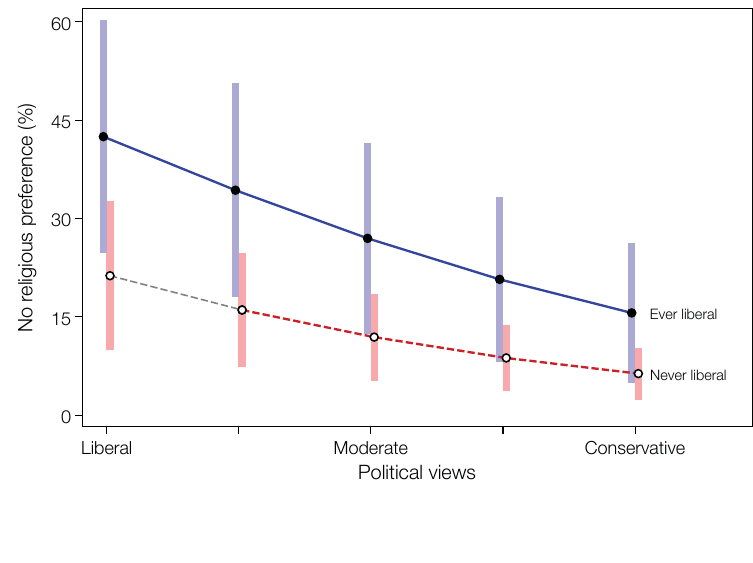
Figure 8a: Percentage with No Religious Preference by Political Views: Persons Born 1966–1975, Raised with Religion, Attended Religious Services Less Than Once a Month, 2012.